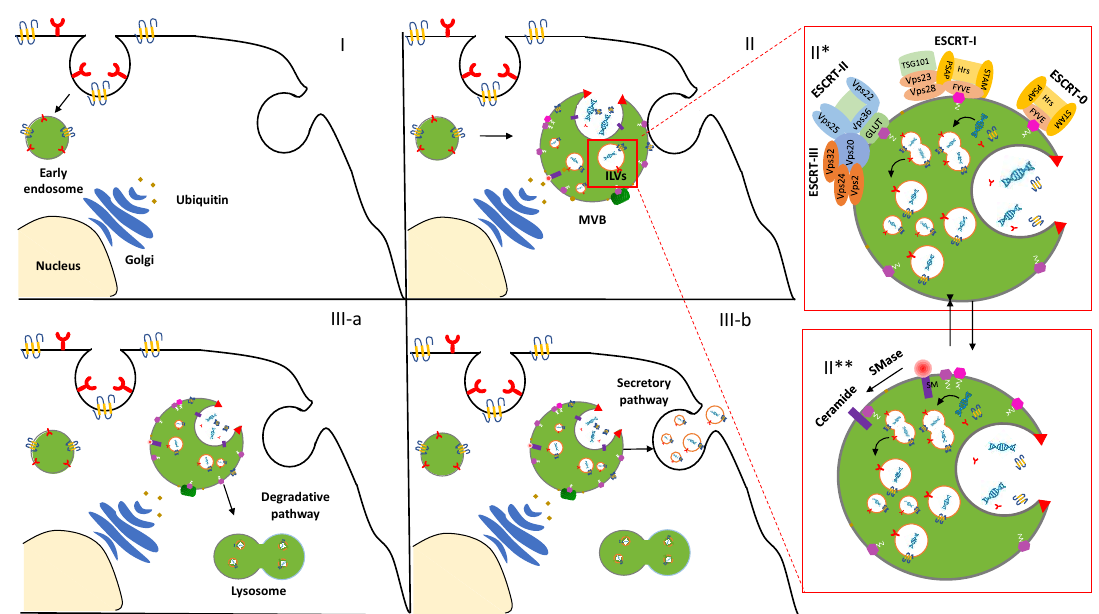
Figure 1. Biogenesis and secretion of exosomes. After the endocytosis of the plasma membrane, the transmembrane proteins are sorted into the vesicles that bud from the cellular membrane into “early endosomes” (I). The biogenesis of the exosome begins with the progressive formation and accumulation of ILVs inside MVBs (II). This process is mediated via an ESCRT-dependent (II*) and / or independent (II**) pathway. Then, the MVBs may follow a degradation pathway fusing with lysosomes or are destined to release the ILVs as exosomes to the extracellular space by exocytosis (III).